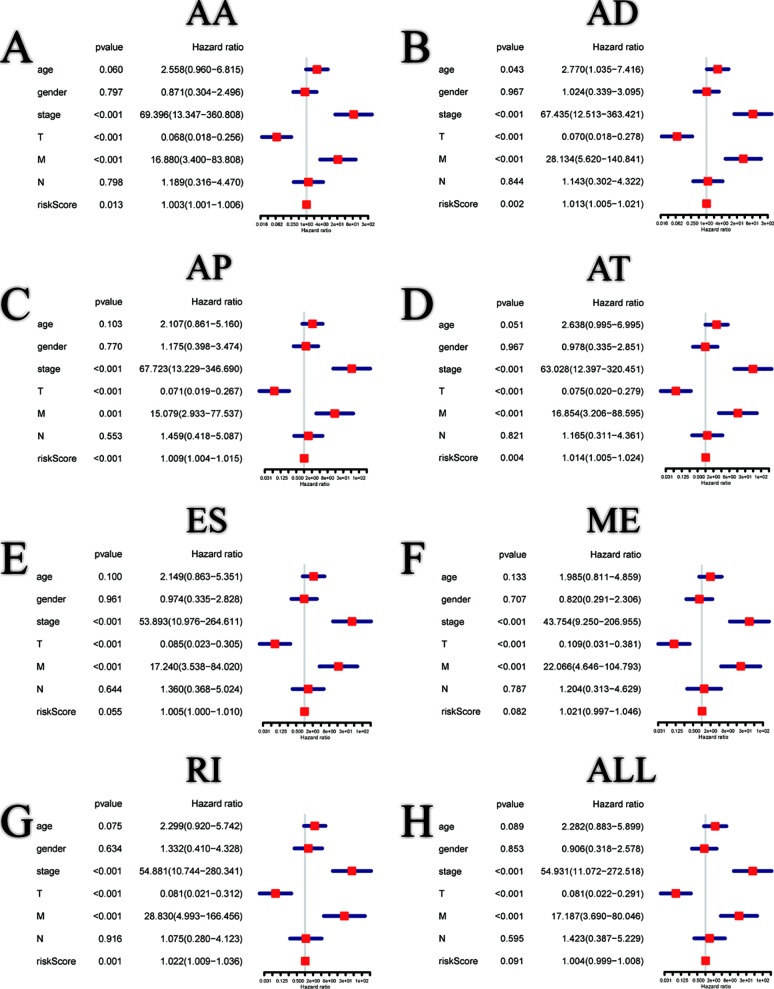
Multivariate Cox regression analysis of clinical parameters and different PI models constructed by AA (A), AD (B), AP (C), AT (D), ES (E), ME (F), RI (G) and all AS events (H) in pRCC patients.